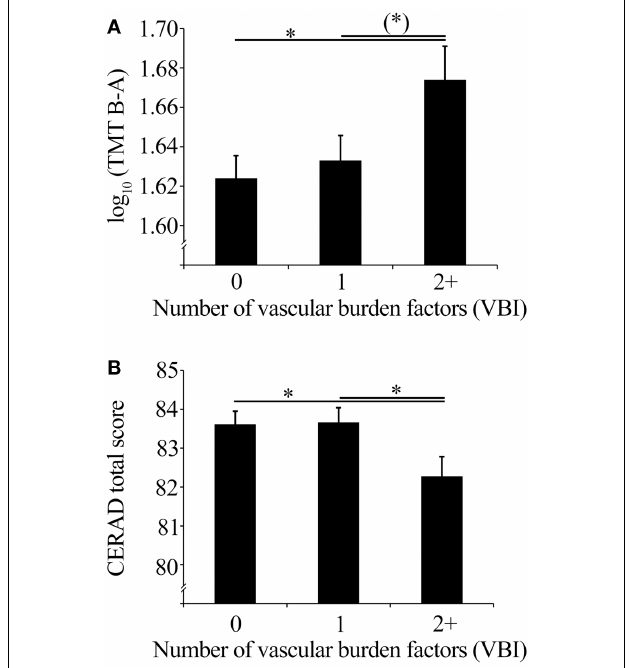
FIGURE 2 | (A) MeanTMT performance (with SEM) corrected for age, sex, and education of theVBI groups, and (B) mean CERAD total scores (with SEM) corrected for age, sex, and education of theVBI groups.